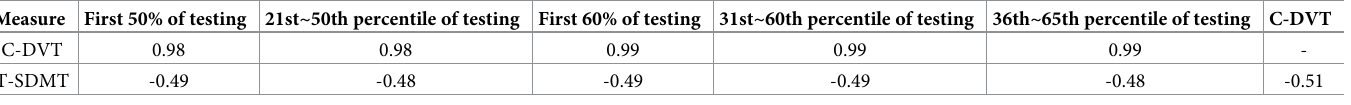
Table 2. Concurrent validity and convergent validity of the 5 segments of the C-DVT (Pearson’s r, n =